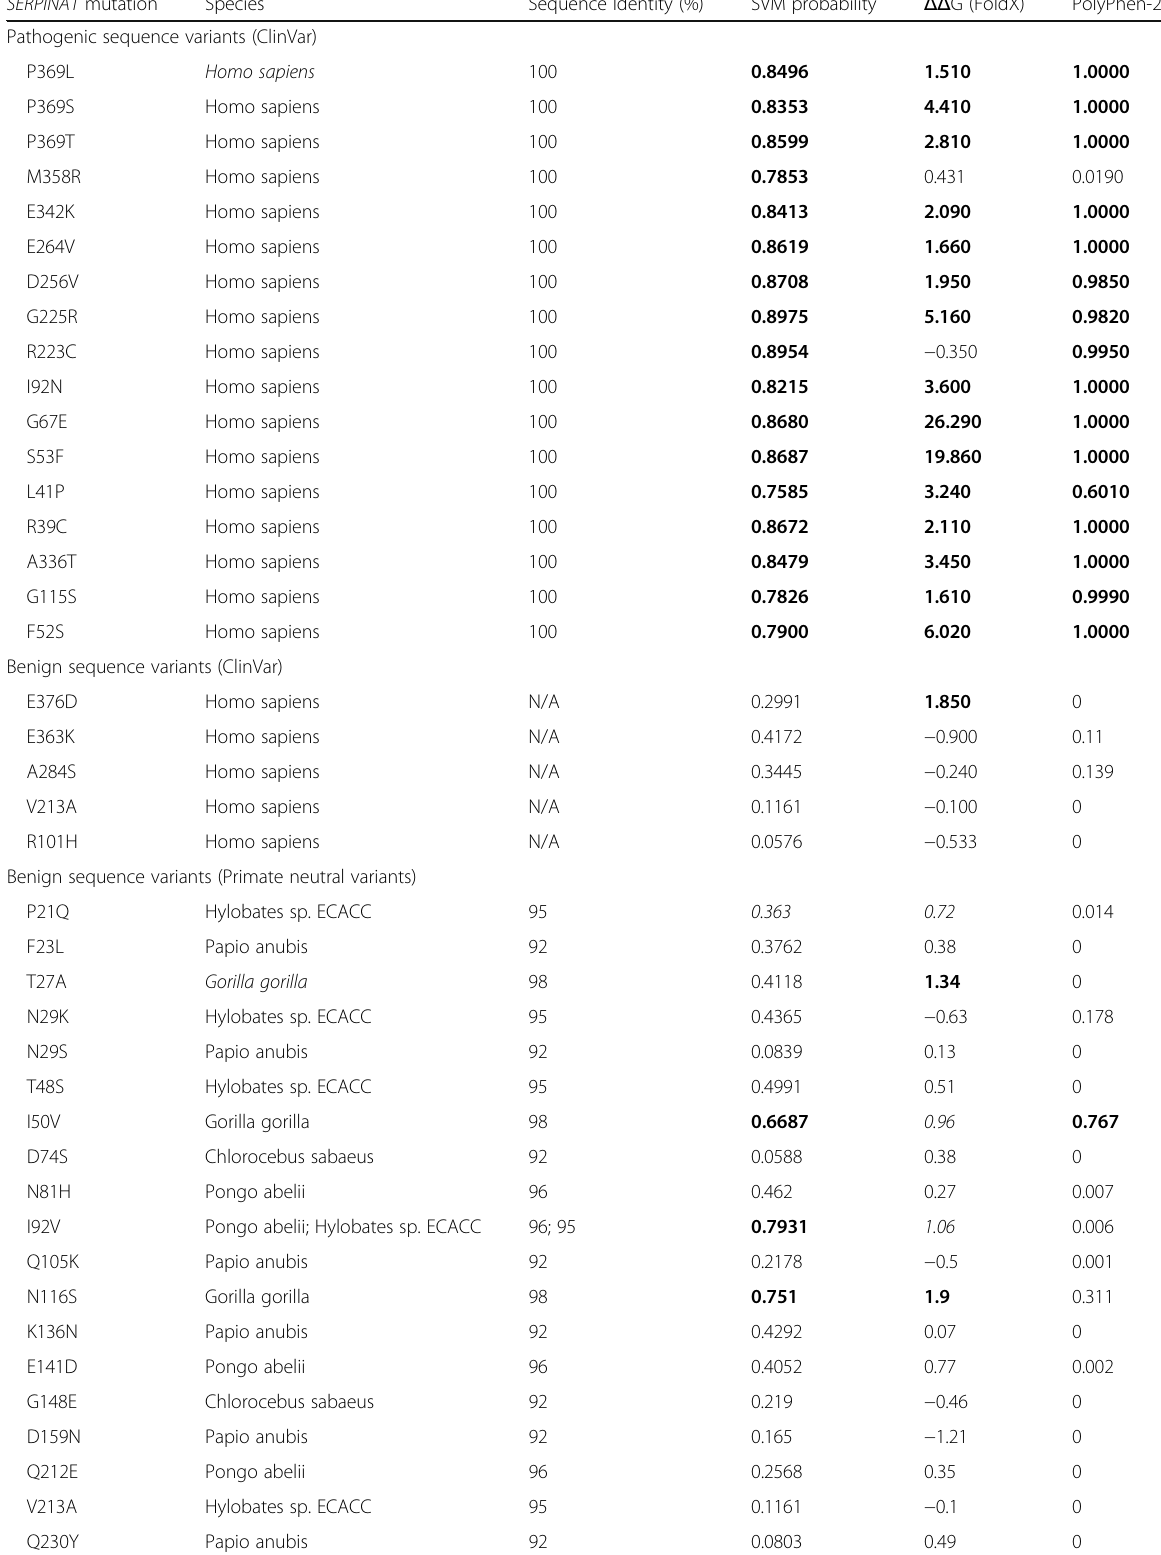
Table 3 Results of benchmarking